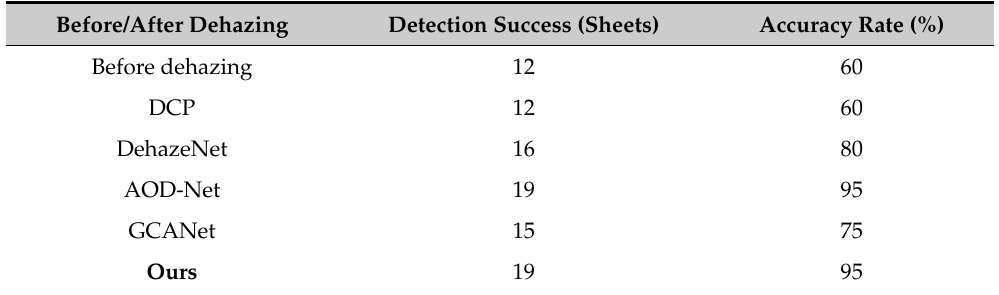
Table 5. Comparison of detection accuracy of sea antenna after dehazing in different networks. Before/After Dehazing Detection Success (Sheets)